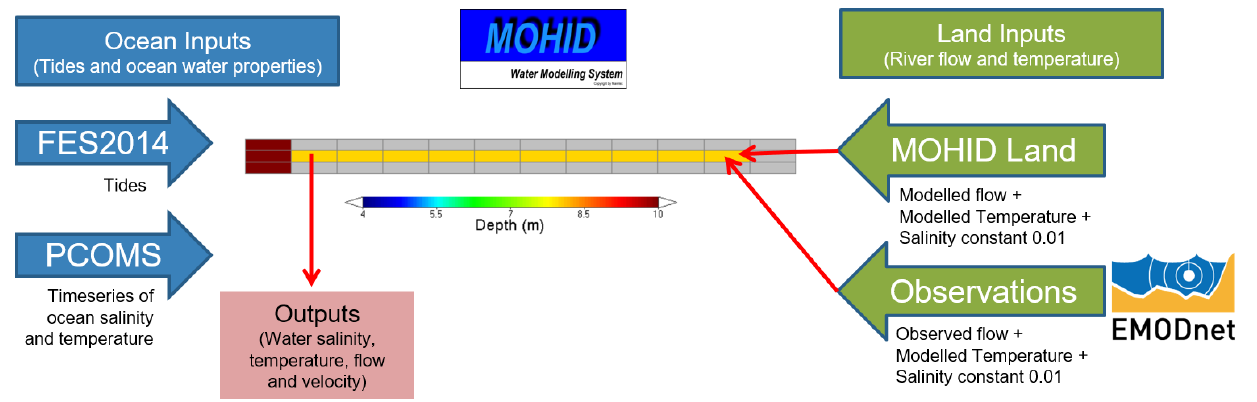
Figure 2. MOHID Water Estuarine schematic model design used for simulating an estuarine proxy. The domain consists of a 12 × 3 grid that receives land inputs (river flow, temperature and salinity) and ocean inputs from tides and regional ocean models (water level, currents, temperature, and salinity) to produce outputs at the estuarine mouth, outputs such as salinity, temperature, flow, and velocity.